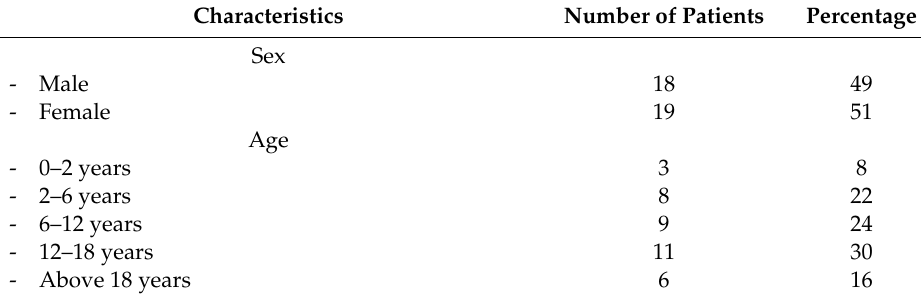
Table 1. Main characteristics of enrolled